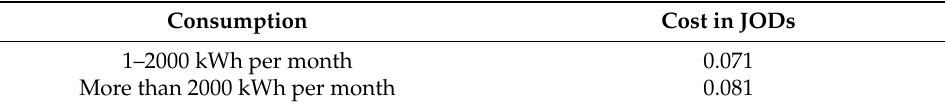
Table 8. Tariffs for small